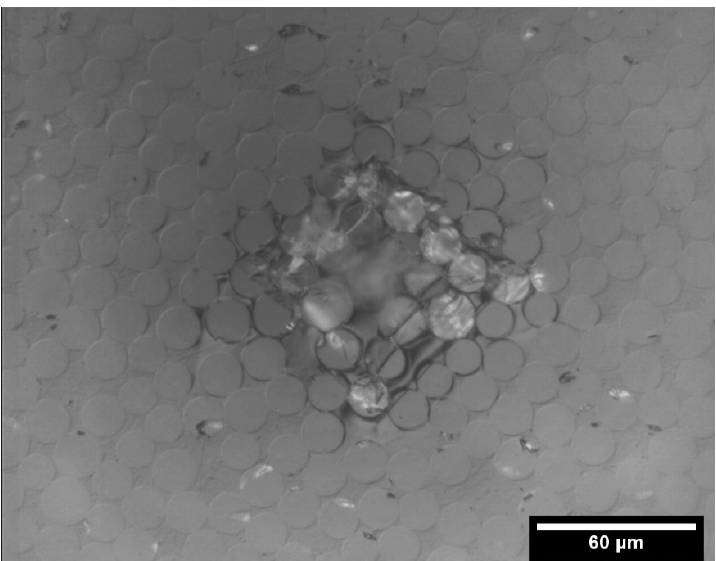
Figure 19. Image of an indenter imprint on the flat side surface of sample C3, 500×. Cracks and chipping of fiber fragments and resin damage in the area of the indenter operation are visible.